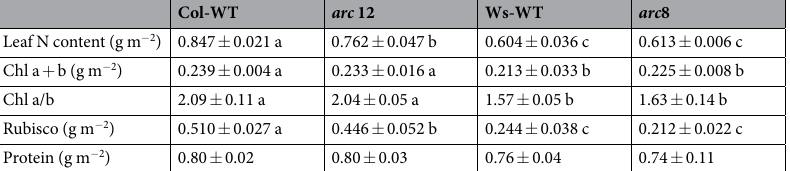
Table 3. Leaf chemical features The values shown are the mean ± SD of three replicates. The means were compared with a least significant difference (LSD) test; values followed by the same letter are not significantly different ( P <